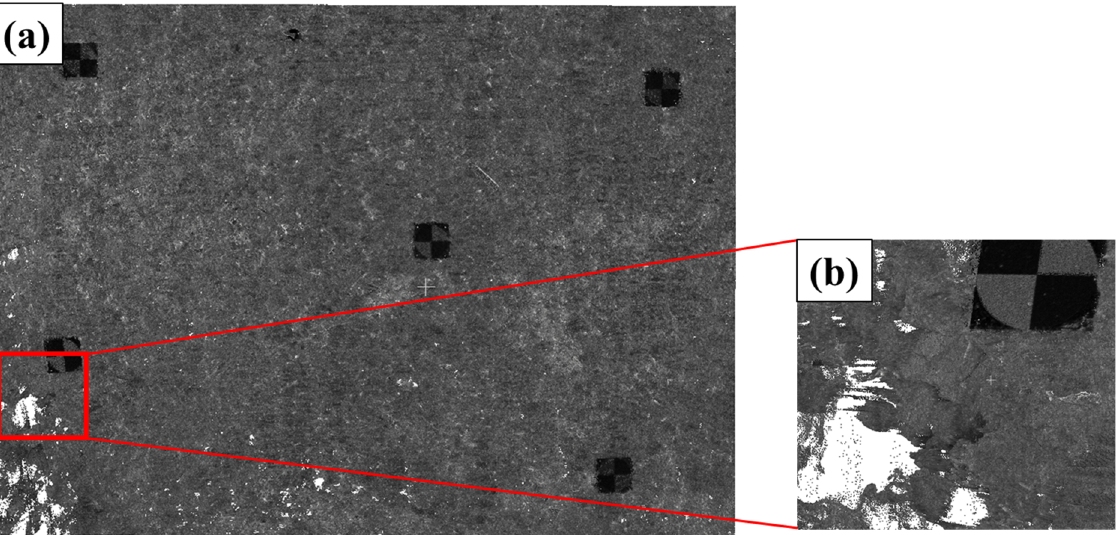
Figure 12. Missing data due to occlusion. ( a ) overview of laser point cloud and ( b ) area with sig- nificant missing data.